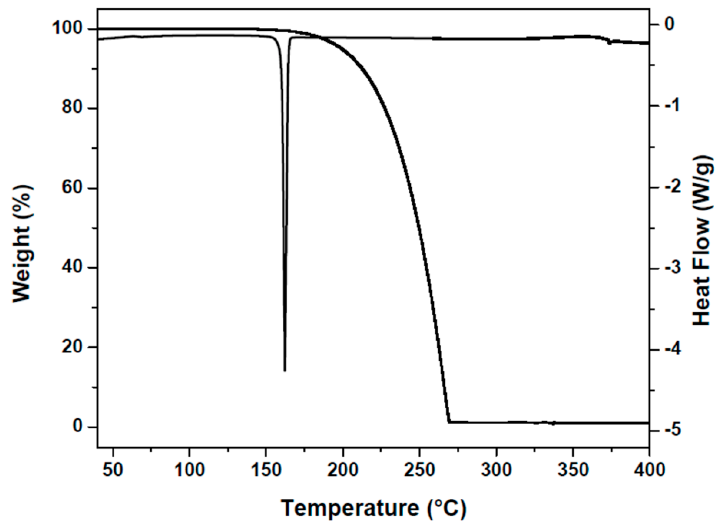
Figure 4. TGA and DSC curves of the quinolin-8-yl 4-chlorobenzoate ( 3